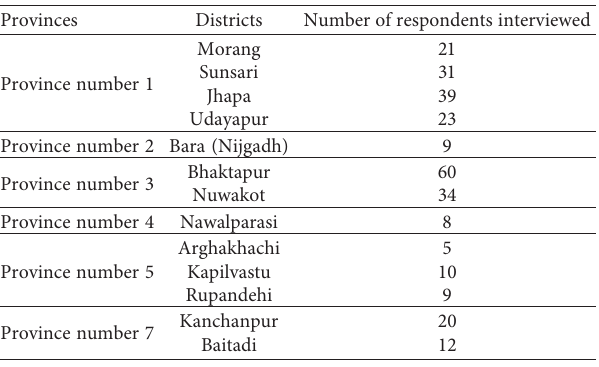
Figure 1: Map of Nepal with the study Table 1: Description of the study area.